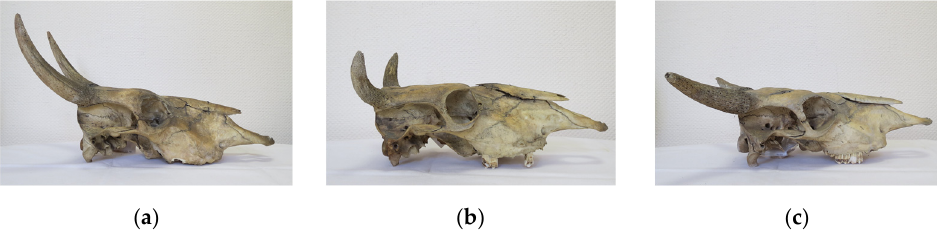
Figure 1. Museum skulls of cattle breeds used for the the study dated by the first quarter of 20th century: ( a )—Kalmyk, ( b )—Kyrgyz, ( c )—Kazakh. The modern samples of Kalmyk (KALM_M, n = 28), Kyrgyz (KRGZ_M, n = 20), and Kazakh white-headed (KZWH_M, n = 30) cattle were derived from the Bioresource collec- tion “Bank of genetic materials of domestic and wild animals and birds” of the L.K. Ernst Federal Research Center for Animal Husbandry. Tissue samples (ear skin) from modern